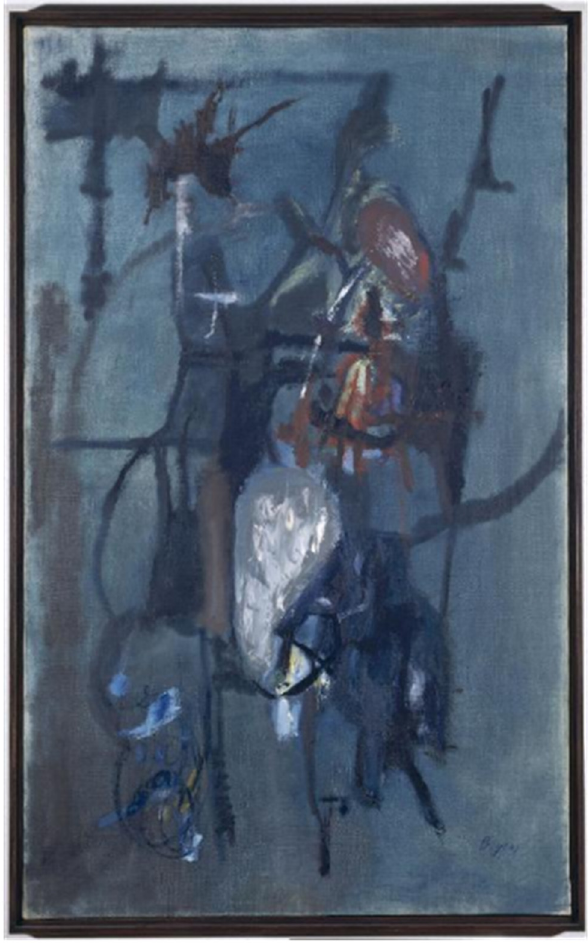
Figure 4. Camille Bryen, Hépérile, 1951. Oil on canvas, 146 × 89 cm. Paris, Musée National d’Art Moderne/Centre Pompidou. Copyright ADAGP.